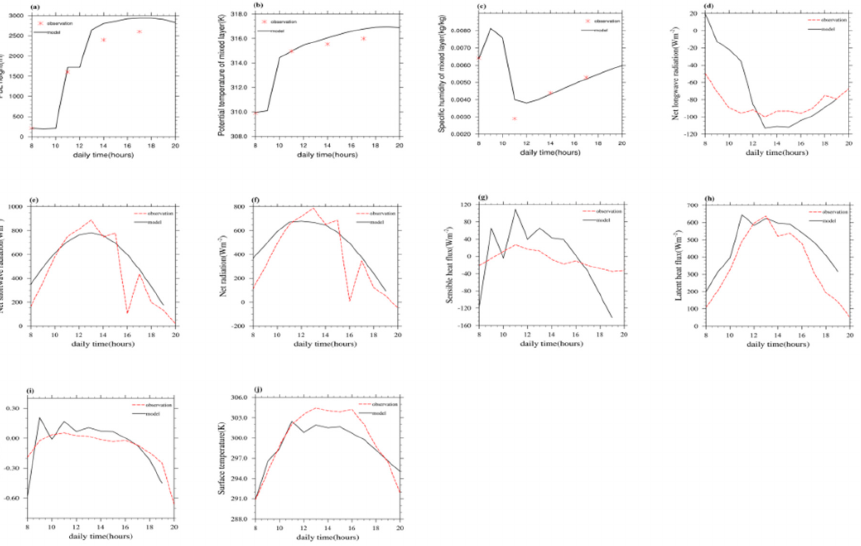
Figure 4. Verifications of simulated PBL height, potential temperature, specific humidity of mixed layer, net longwave radiation, net shortwave radiation, net radiation, sensible heat flux, latent heat flux, Bowen ratio, and surface temperature against observations using data from 28 June 2016, with soil saturation 0.33. ( a ): planetary boundary layer height ( b ): planetary boundary layer potential temperature ( c ): planetary boundary layer specific humidity ( d ): net longwave radiation ( e ): net shortwave radiation ( f ): net radiation ( g ): sensible heat flux ( h ): latent heat flux ( i ): Bowen ratio ( j ): surface temperature.